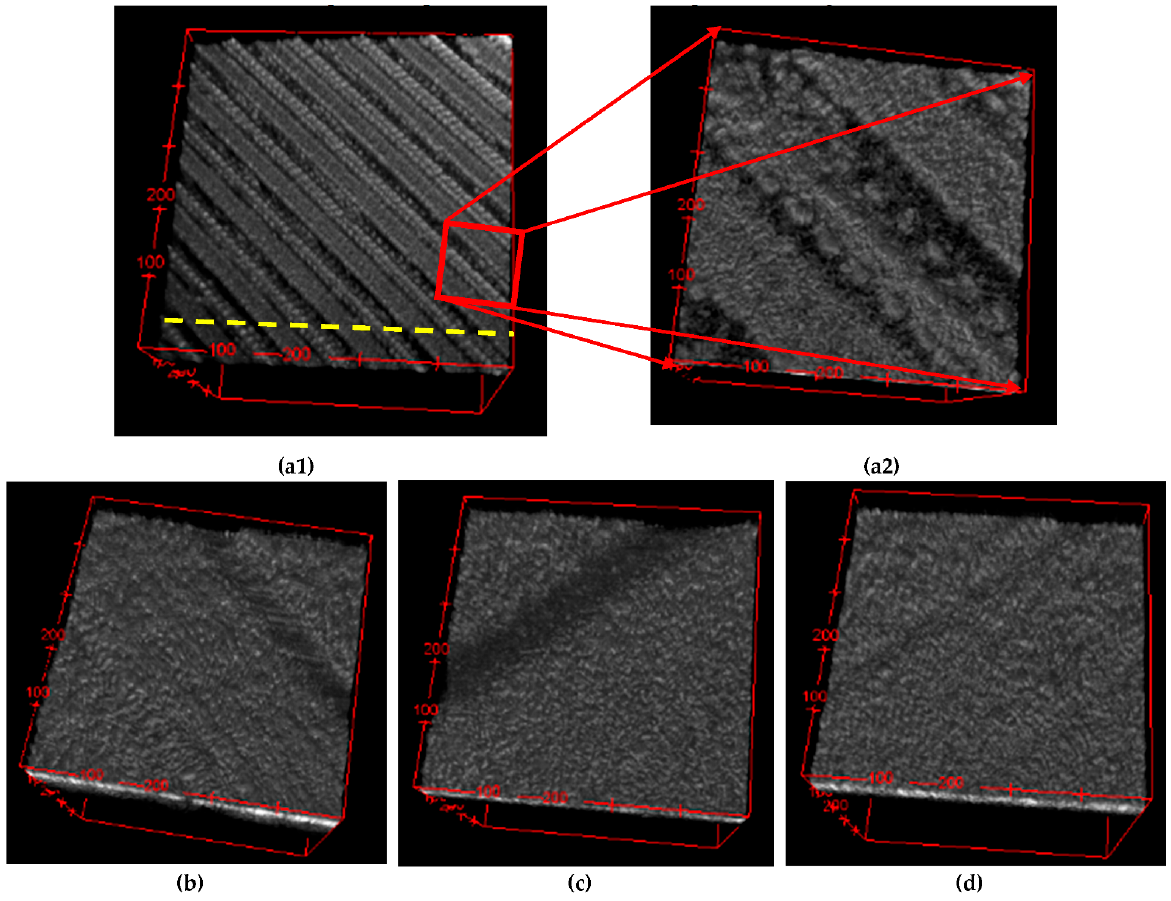
Figure 5. Details of 3D OCT reconstructions of sample plates situated in the biogas reactor: ( a1 ) control plate with a surface area of 3.5 × 3.5 mm 2 —with a dashed line indicating the direction of the optical cross-sections/B-scans that are presented in the following figures; ( a2 ) detail of a portion of the control plate with a surface area of 0.7 × 0.7 mm 2 , selected to show the surface topography; ( b ) detail of a top plate; ( c ) detail of a middle plate; ( d ) detail of a bottom plate. All images in the second row were selected in a similar way to the one in Figure 5a; they correspond to a surface area of 0.7 × 0.7 mm 2 .